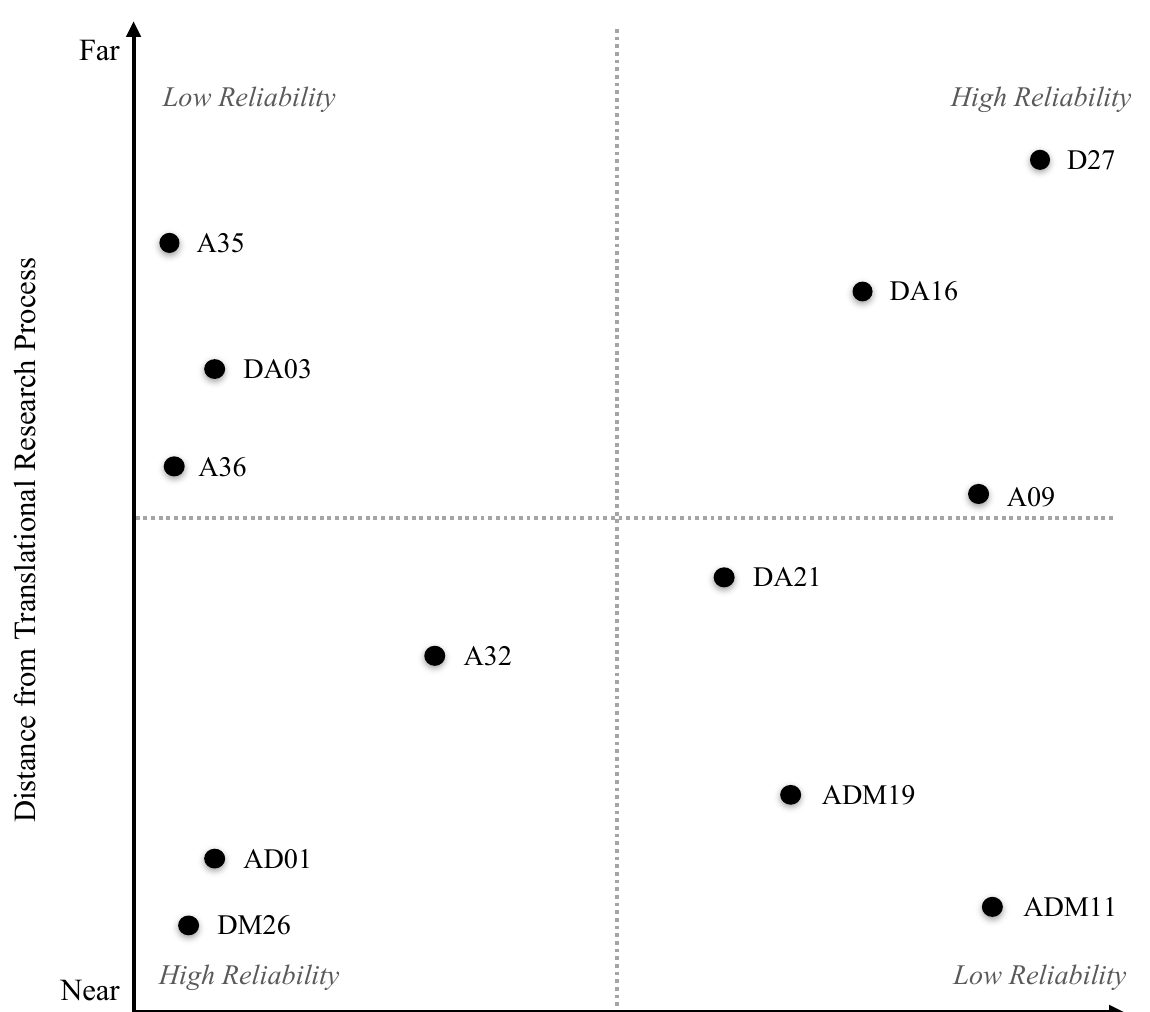
Figure 1: Plot describing how an individual’s position in crisis science and their distance from the translational research process influence their view of the reliability of the final research output. Highly embedded researchers who are also near to the process are more likely to view the output as having “high reliability” (e.g., DM26,